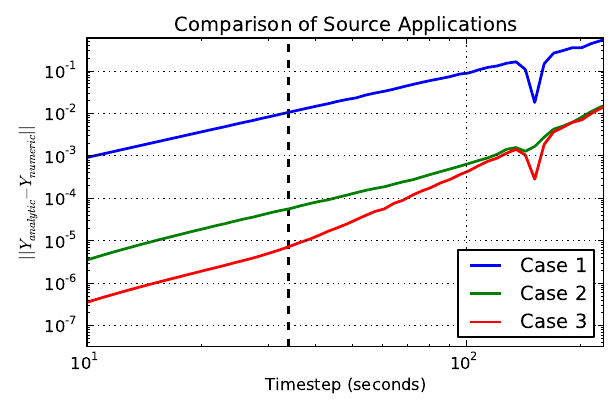
Fig. 12. Convergence curves for three separate simulations that split out the source term from the Crank-Nicolson solver. Case 1 uses a simple second-order accurate source solver, while Cases 2 and 3 use a fourth order source solver. The variety in the curves demon- strate the importance of properly selecting a solver along with an appropriate grid size and time